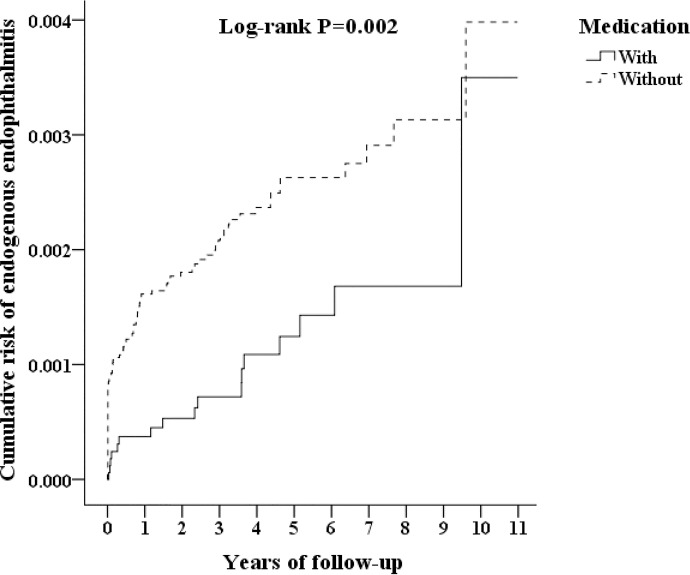
Kaplan-Meier curve for the cumulative incidence of endogenous endophthalmitis among patients aged 18 and stratified by medication use with the log-rank test.